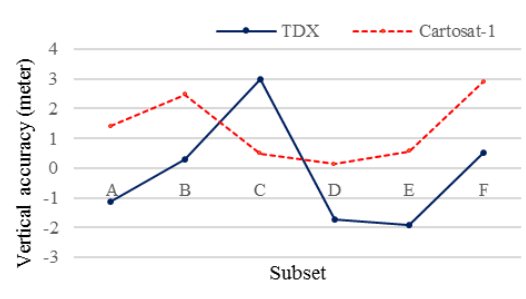
Figure 6. Height residual map for high building: TanDEM-X DEM (Left) and Cartosat-1 DEM (Right)